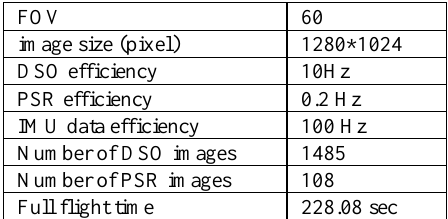
Table 4. Settings for the full system